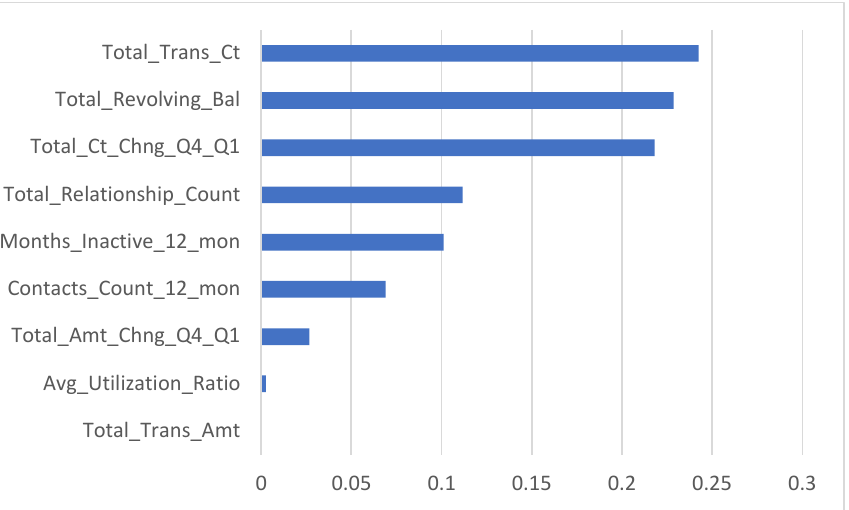
Figure 5. The importance of variables for Model 3 after applying C5 tree customer churn model.